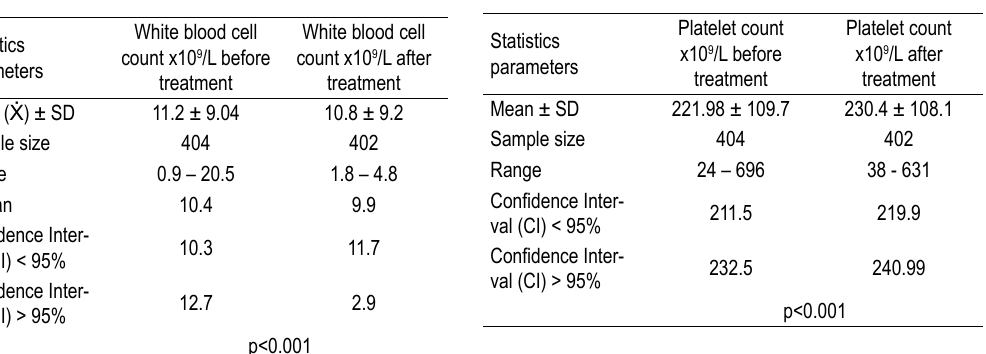
Table 7. changes of platelet count before and after transfu-